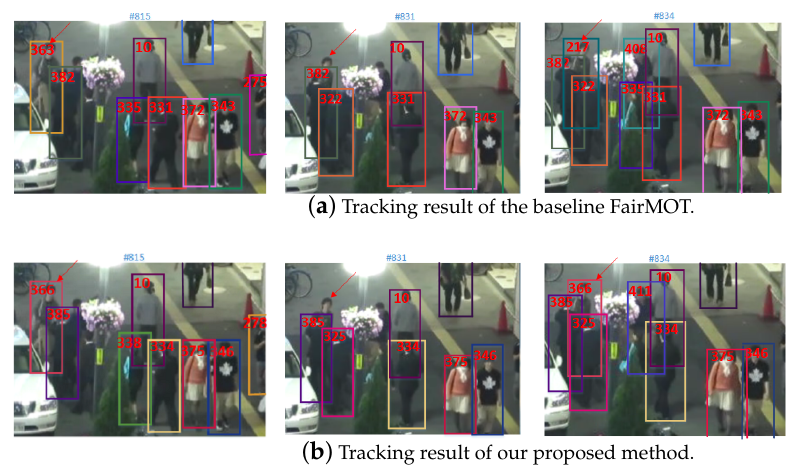
Figure 7. Comparison of our method and the baseline method. We compare the same video data of MOT16. The red arrow points to the object we used for the tracking-performance comparison. It can be seen from the figure that, when using the FairMOT method for tracking, the ID of the object changes from 363 to 217 after occlusion. However, when using our method for tracking, the ID remains at 366 after occlusion. Table 4. Comparison of the baseline method on Multiple Object Tracking Benchmark.